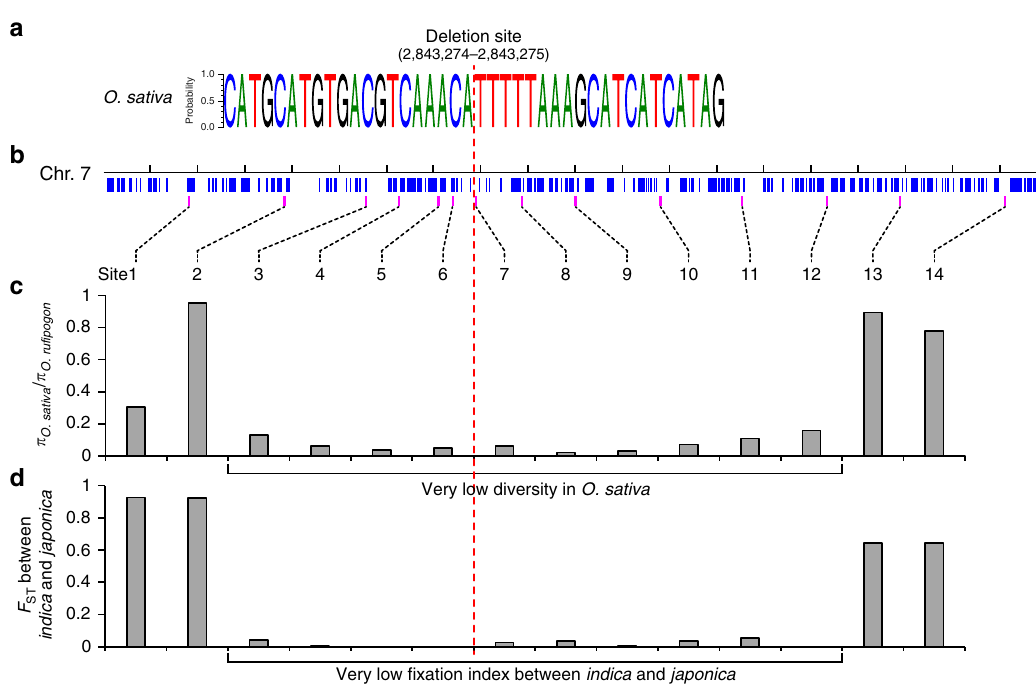
Fig. 4 Nucleotide diversity and fi xation index across the deletion site on chromosome 7. a The consensus sequence covering the breakpoint of deletion in 133 Asian rice varieties. All surveyed Asian rice cultivars had an identical deletion. The breakpoint of deletion located between 2,843,274 and 2,843,275 bp on chromosome 7 in the Nipponbare reference genome (Os-Nipponbare-Reference-IRGSP-1.0, MSU7). b The location of 14 sampled loci within the ~1 Mb genomic region surrounding the deletion site on chromosome 7. The position of each loci was showed in Supplementary Data 5. c The relative ratio of nucleotide diversity ( π ) in O. sativa to O. ru fi pogon shows the ~500 kb selective sweep surrounding the deletion site in Asian cultivated rice. d The fi xation index ( F ST ) between indica and japonica cultivars at the 14 sampled loci. The dashed red line indicates the deletion site in the genome of O. sativa